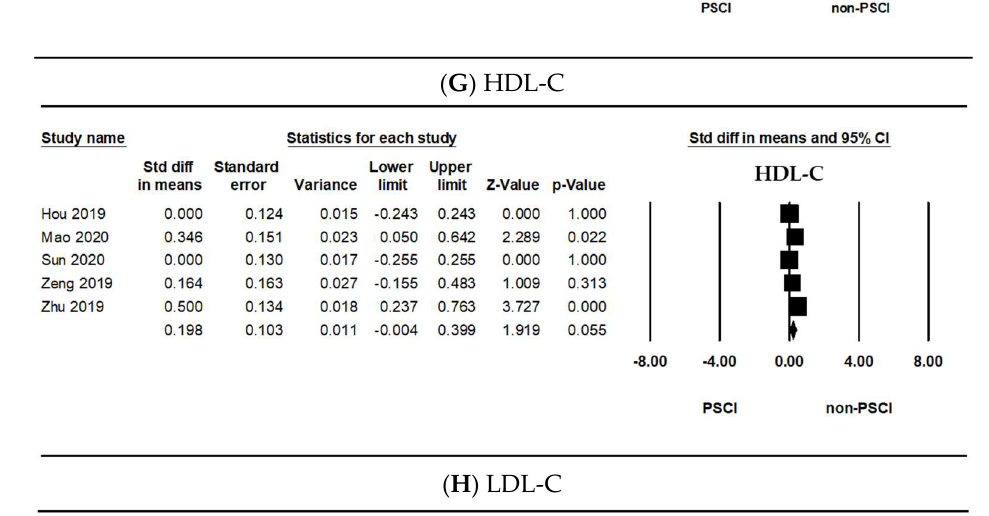
publication bias (Figure 2A: p = 0.11, 2B: p = 0.10, 2C: p = 0.84, 2D: p = 0.66, 2E: p = 0.30, 2F: p = 0.76, 2G: p = 0.56, 2H: p = 0.57). Data that were included in this meta-analysis are shown in Supplementary Table S1.